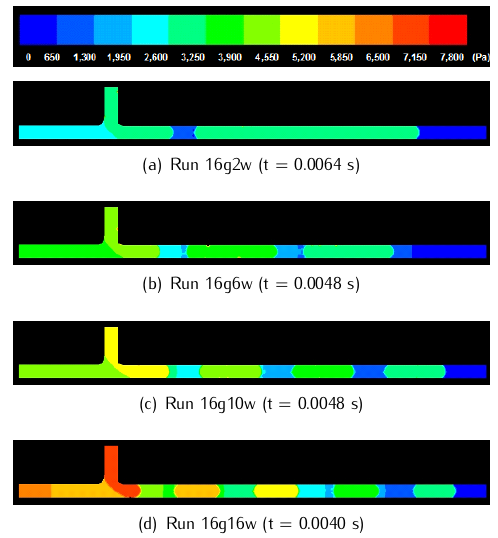
Figure 16. Static pressure of selected runs during slug formation at T-junction